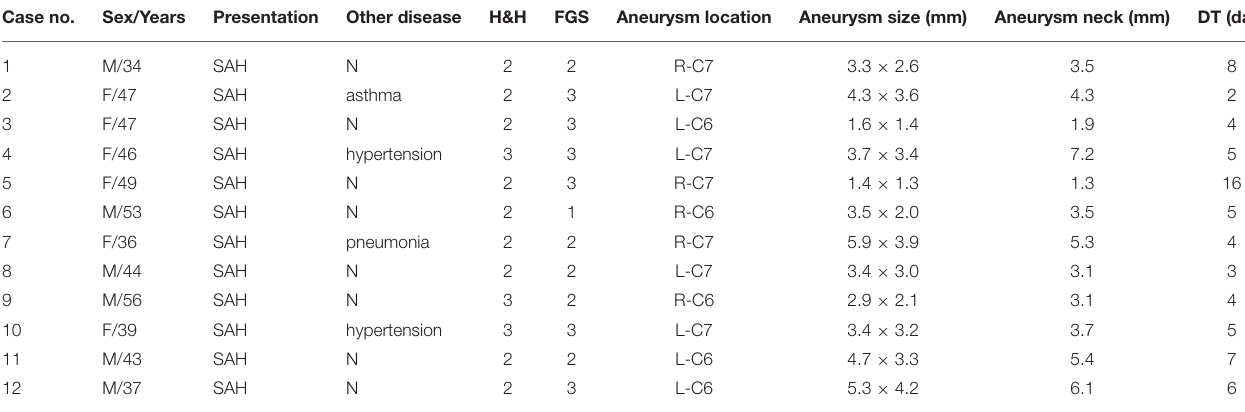
TABLE 1 | Baseline clinical and imaging characteristics. Case no.